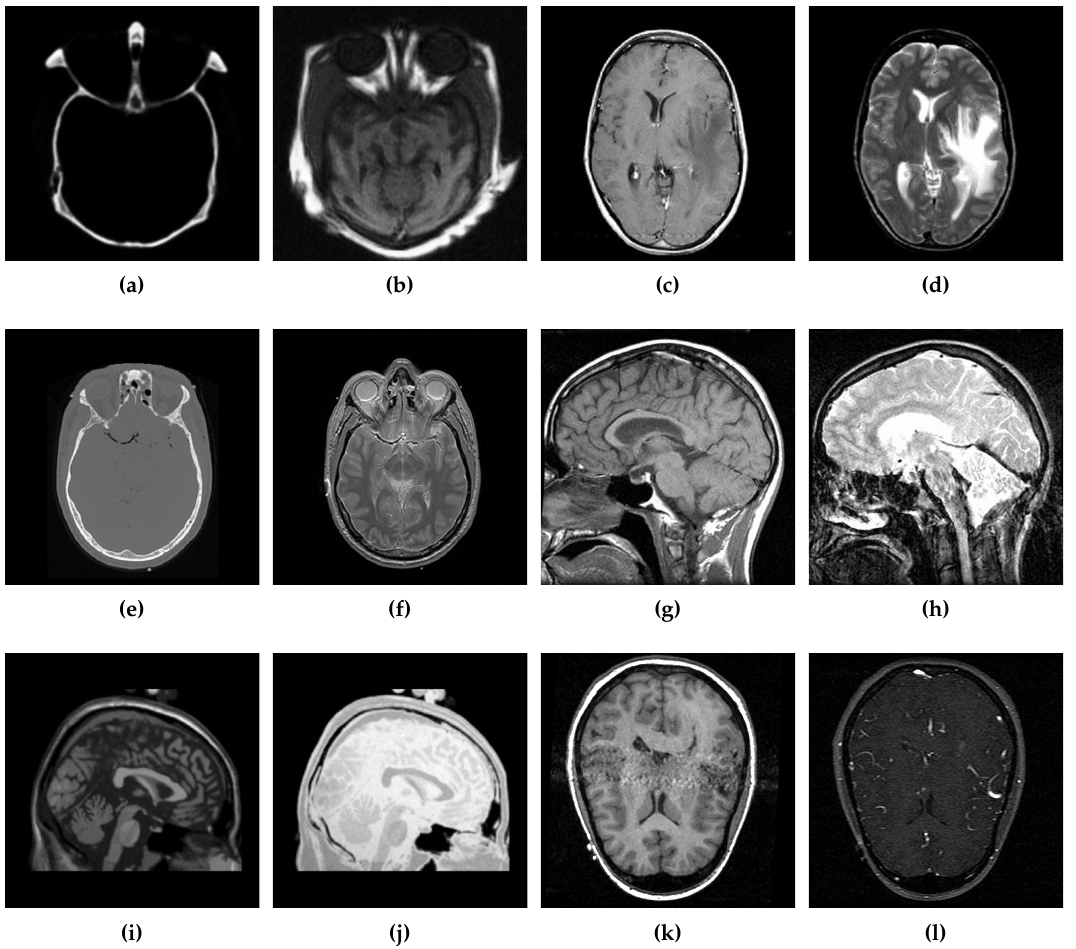
Figure 4. Sample source images from the given datasets (Data-1 through Data-6), where ( a , b ) ∈ Data-1, ( c , d ) ∈ Data-2, ( e , f ) ∈ Data-3, ( g , h ) ∈ Data-4, ( i , j ) ∈ Data-5, and ( k , l ) ∈